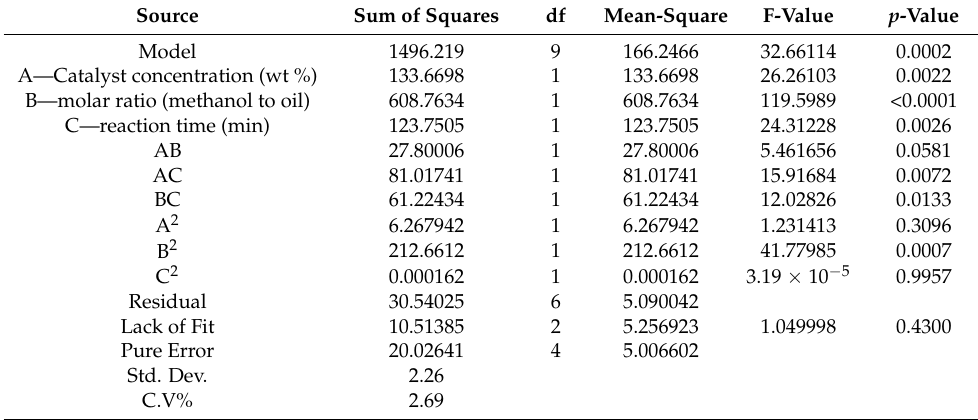
Table 7. Analysis of variance (ANOVA) for response surface methodology (RSM)